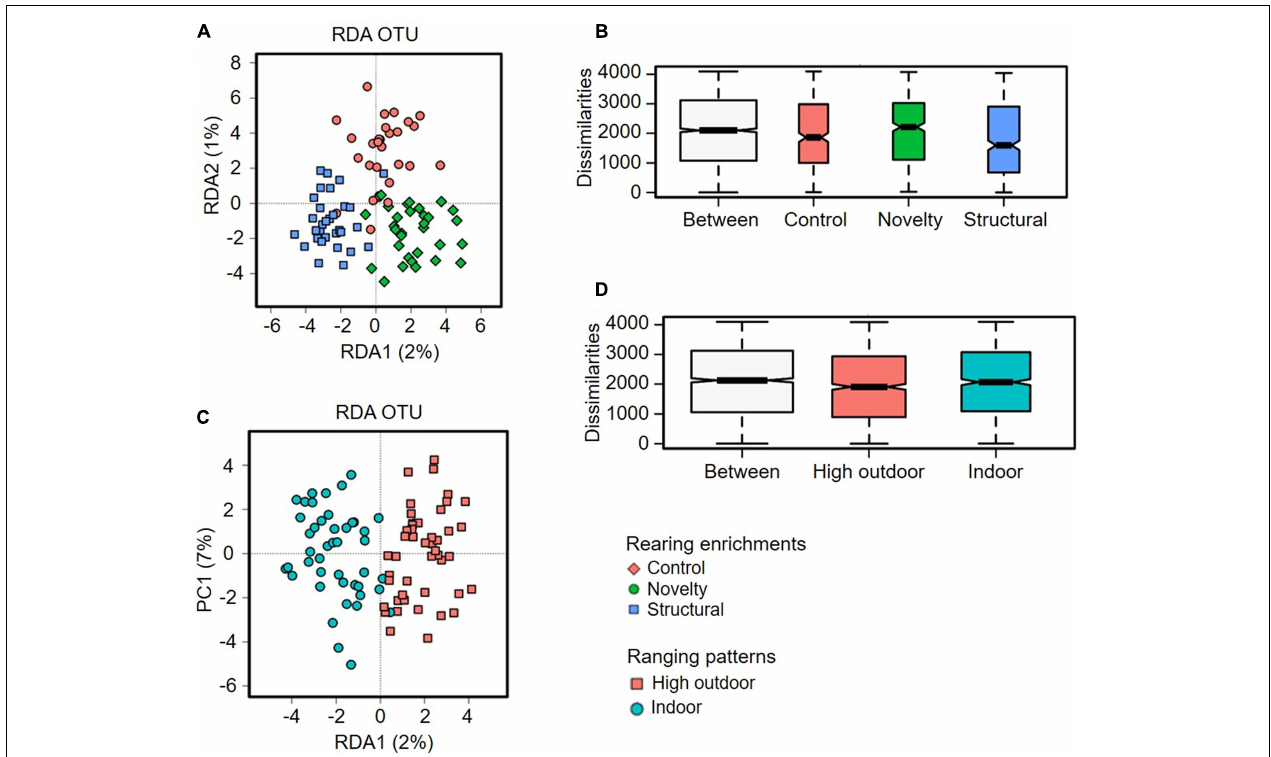
FIGURE 10 | Microbial diversity (Beta-diversity) of cecal microbiota of free-range hens at 65 weeks of age from different rearing enrichments (control, novelty, structural) and ranging patterns (high outdoor, indoor) at ASV level. (A) Redundancy analysis (RDA), P = 0.001; (B) ANOSIM (Bray-Curtis), P = 0.001. Microbial diversity of cecal microbiota of free-range hens at 65 weeks of age from different ranging patterns (high outdoor, indoor); (C) Redundancy analysis (RDA), P = 0.006; (D) ANOSIM (Bray–Curtis), P =